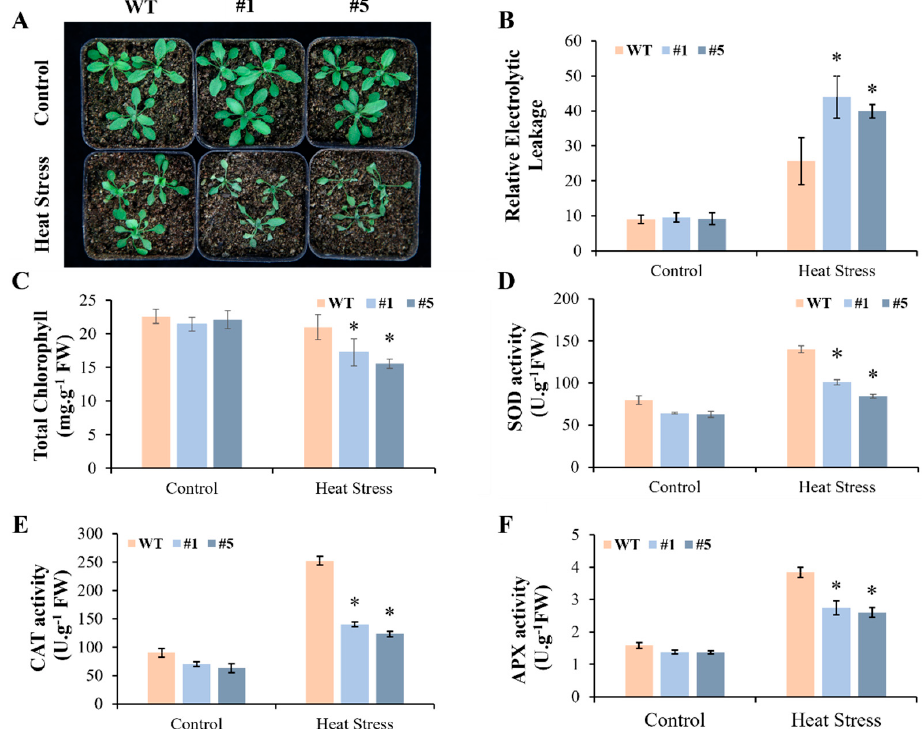
Figure 6. Phenotypic analysis and physiological index determination of overexpression CmHSP90.5 in Arabidopsis under heat stress. ( A ) Phenotype of normal plants and plants under heat stress. ( B ) The relative electrolytic leakage in transgenic lines and Col-0 plants under normal and heat stress. ( C ) Chlorophyll of transgenic lines and Col-0 plants under normal and heat stress. ( D – F ) The activities of SOD, POD, and CAT in transgenic lines and Col-0 plants under normal and heat stress. Statistically significant differences were compared with Col-0 plants under different conditions. Error bars represent ± SE. * Value of p < 0.05 was considered to be statistically significant.